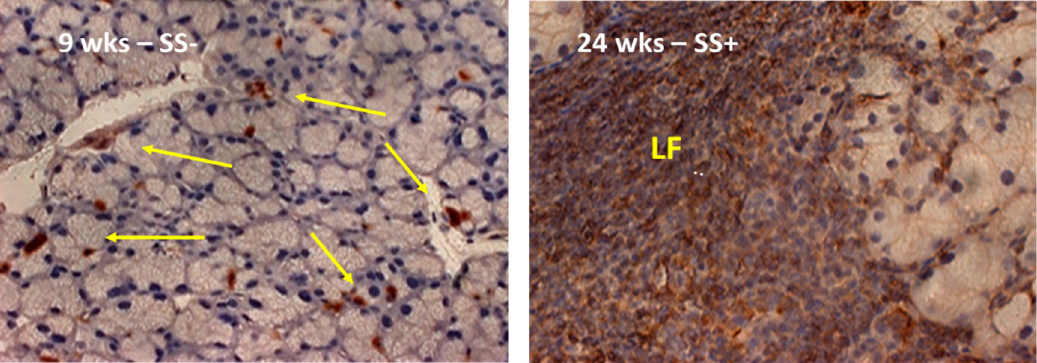
Figure 4. Temporal development of lymphocytic foci (LF) in the lacrimal glands of C57BL/6.NOD ‐ Aec1Aec2 mice. A histological comparison of leukocytic infiltrations within the lacrimal glands revealing the first signs of periductal infiltrations occurring at 9 weeks ( left panel, arrows) versus the presence of highly developed lymphocytic foci (LF) at 24 weeks of age ( right panel). Mice at 24 weeks of age exhibit high levels of SS pathology and clinical disease. Note: These photomicrographs reflect the general histology of the SS S mice and are not of the same glandular tissue explanted from the experimental mice used for the RNA microarrays. This figure is a modification of Figure 3 published previously in the journal of Investigative Ophthalmology & Visual Sciences (Peck, A.B.; Saylor, B.T.; Nguyen, L.; Sharma, A.; She, J.X.; Nguyen, C.Q.; McIndoe, R.A. Gene expression profiling of early ‐ phase Sjögren’s syndrome in C57BL/6.NOD ‐ Aec1Aec2 mice identifies focal adhesion maturation associated with infiltrating leukocytes. Investig. Ophthalmol. Vis. Sci. 2011, 29 , 5647–5655)